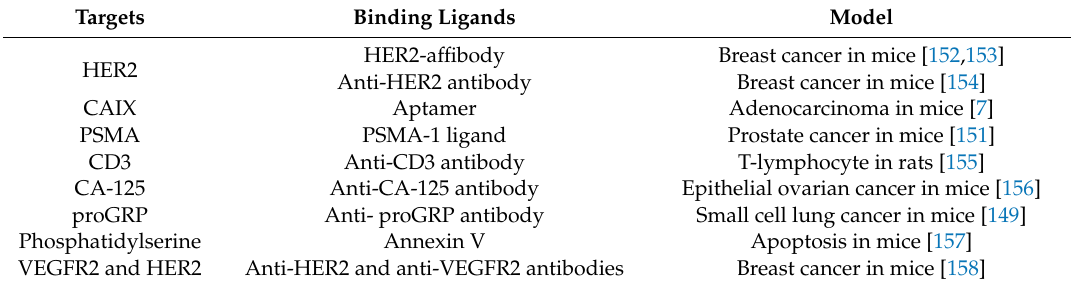
Table 3. Summary of extravascular targets investigated for molecular US